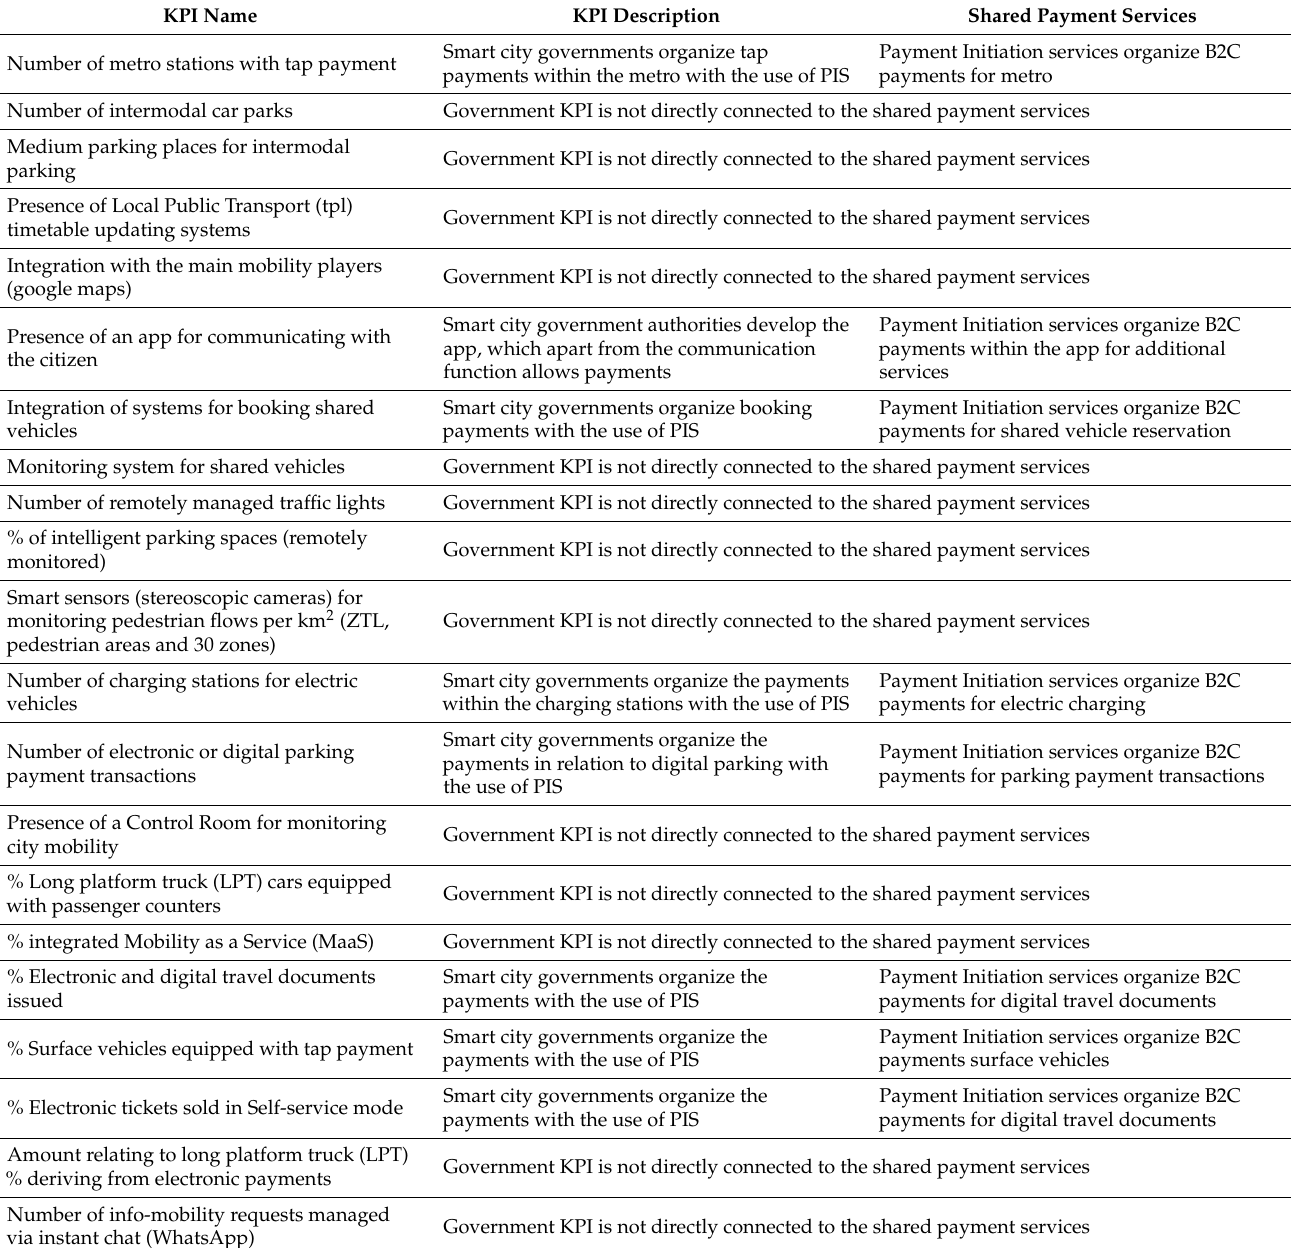
Table 2. KPIs for Rome smart mobility. Source: generated by the authors; the KPIs were taken from O’Leary et al.